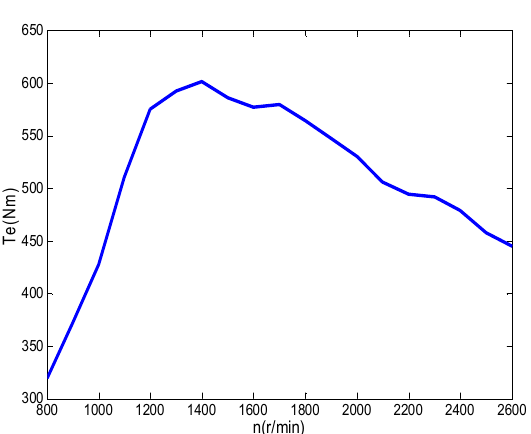
Figure 3. The engine maximum torque curve.